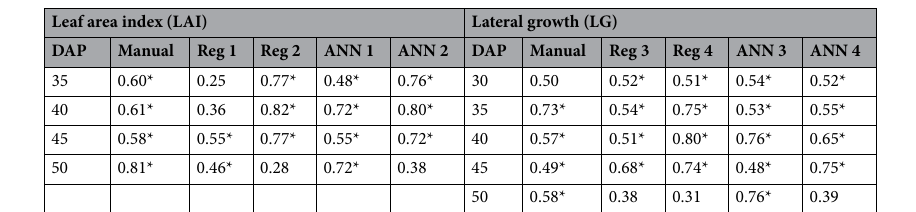
Table 7. Relationship of leaf area index (LAI) and lateral growth (LG) with peanut pod yield at different days after planting (DAP). The values in the table are Coefficient of determination (R 2 ) of LAI and LG with peanut pod yield. The LAI and LG are manually measured and aerially derived using regression and aerial neural network (ANN) models in 2017. The values followed by an asterisk (*) has a significant model at α = 0.05.